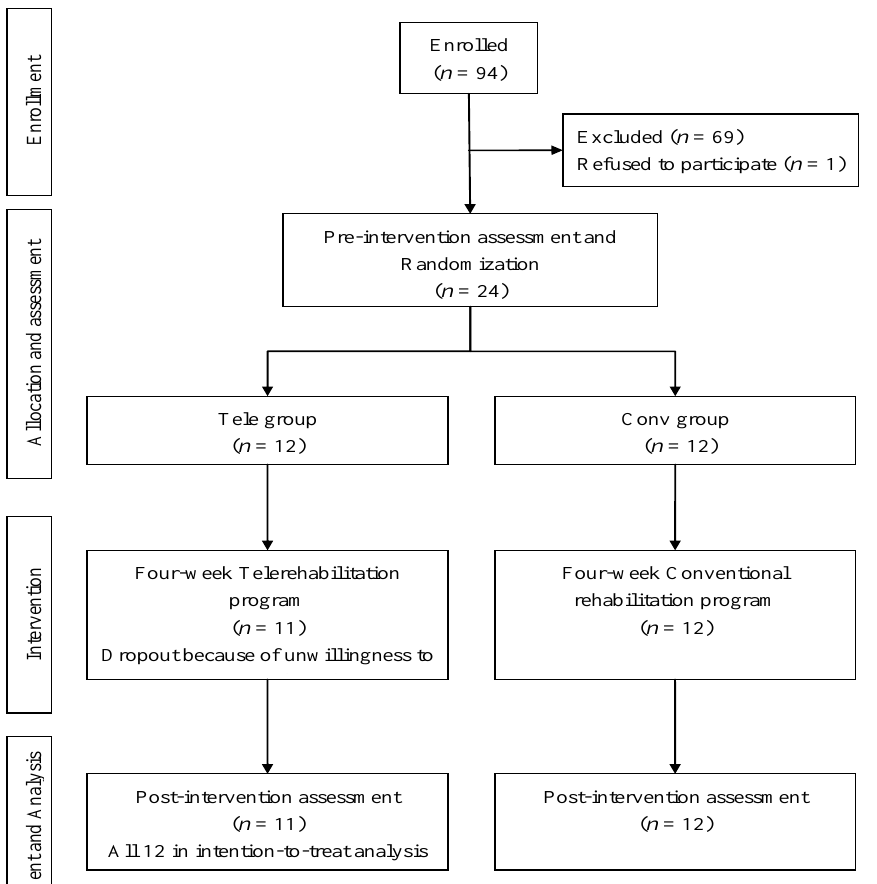
Figure 2. Flow diagram of experimental